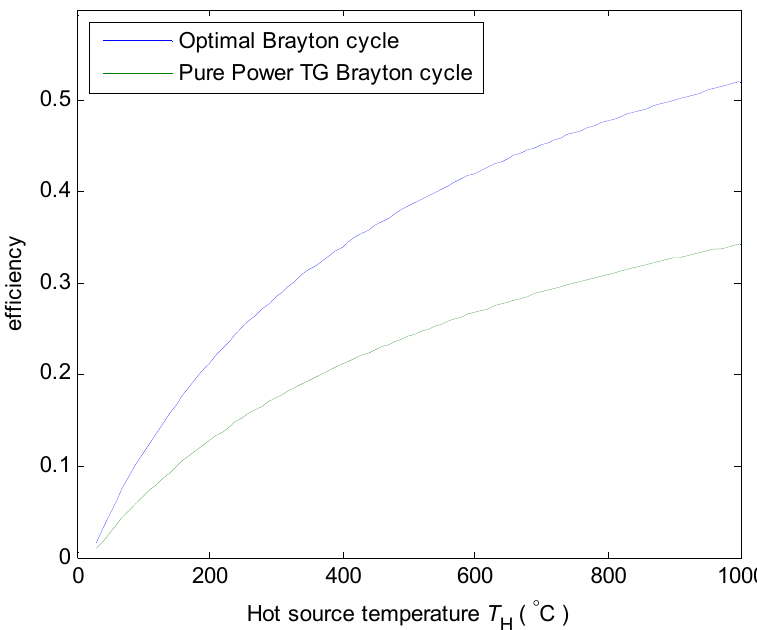
Figure 6. Theoretical efficiency comparison of an optimal and a pure power thermogravitational (TG) Brayton cycle depending on the hot source temperature T H . A pure power cycle requires no work input for the compression process. The working fluid is air and the cold source temperature is equal to 20 °C. The efficiency is expressed relative to 1 (i.e., not as a percentage).